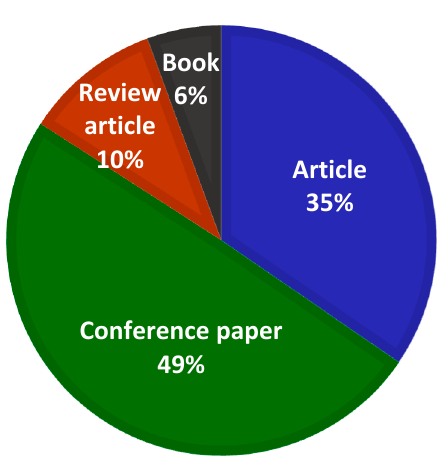
Figure 2. Publications by type. Keywords: blockchain, IoT, smart grids and energy.